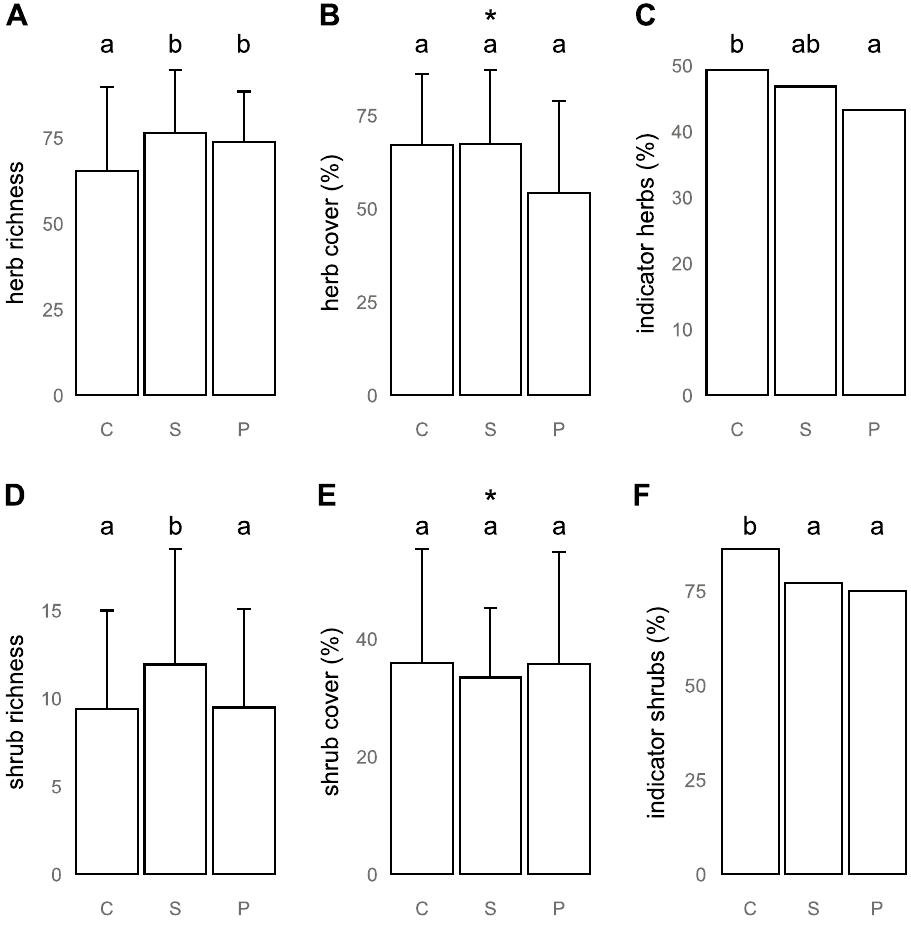
Figure 4. Plant species richness, cover, and share of indicator species of herbs and shrubs on three plot types—crests (C), seasonal rivers (P), and perennial rivers (P). Bars show means for each type of bedrock (n = 20), and error bars show the associated standard deviation (SD). The letters above bars indicate significant differences among the three types of plots (including marginally significant, 0.05 < p < 0.1). Asterisks indicate the significance of the overall model when pairwise contrasts were not